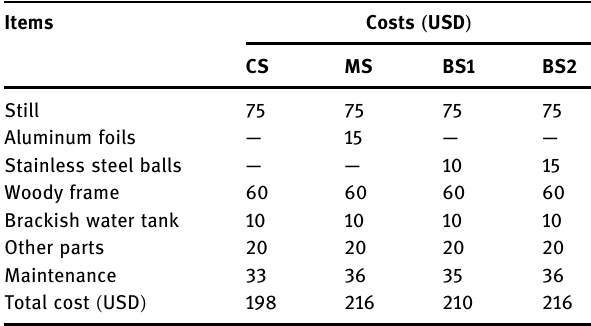
Table 4: Total costs of the solar stills